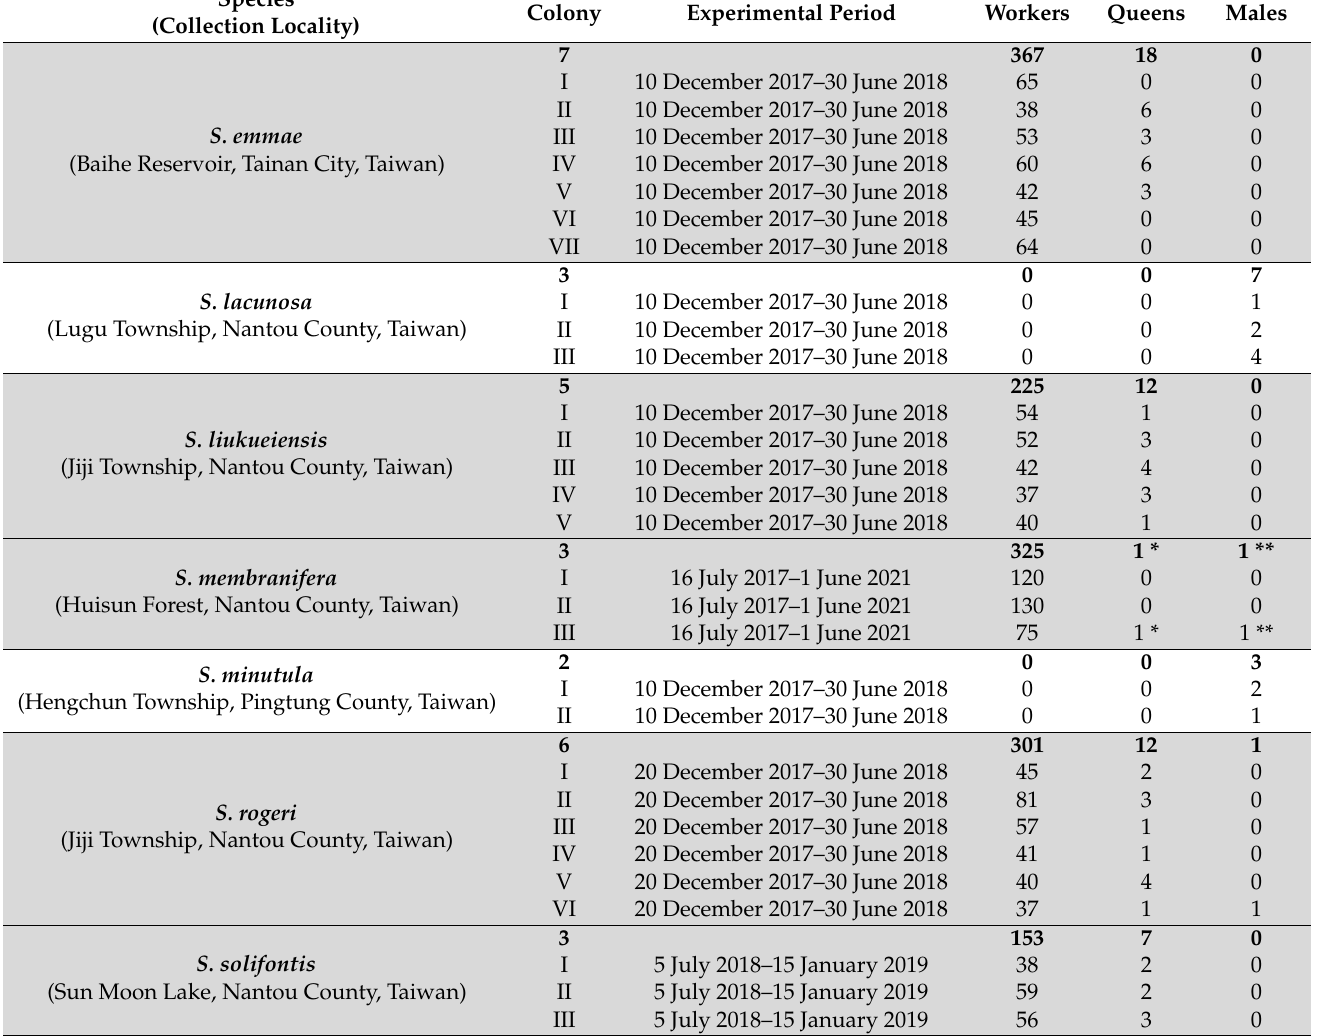
Table 1. Species of which reproduction was studied during experimental period of 28 weeks (for S. membranifera 134 (*) and 202 weeks (**), respectively). Number of adult offspring during this period is listed. Bold values show total per species; grey background indicates thelytokous